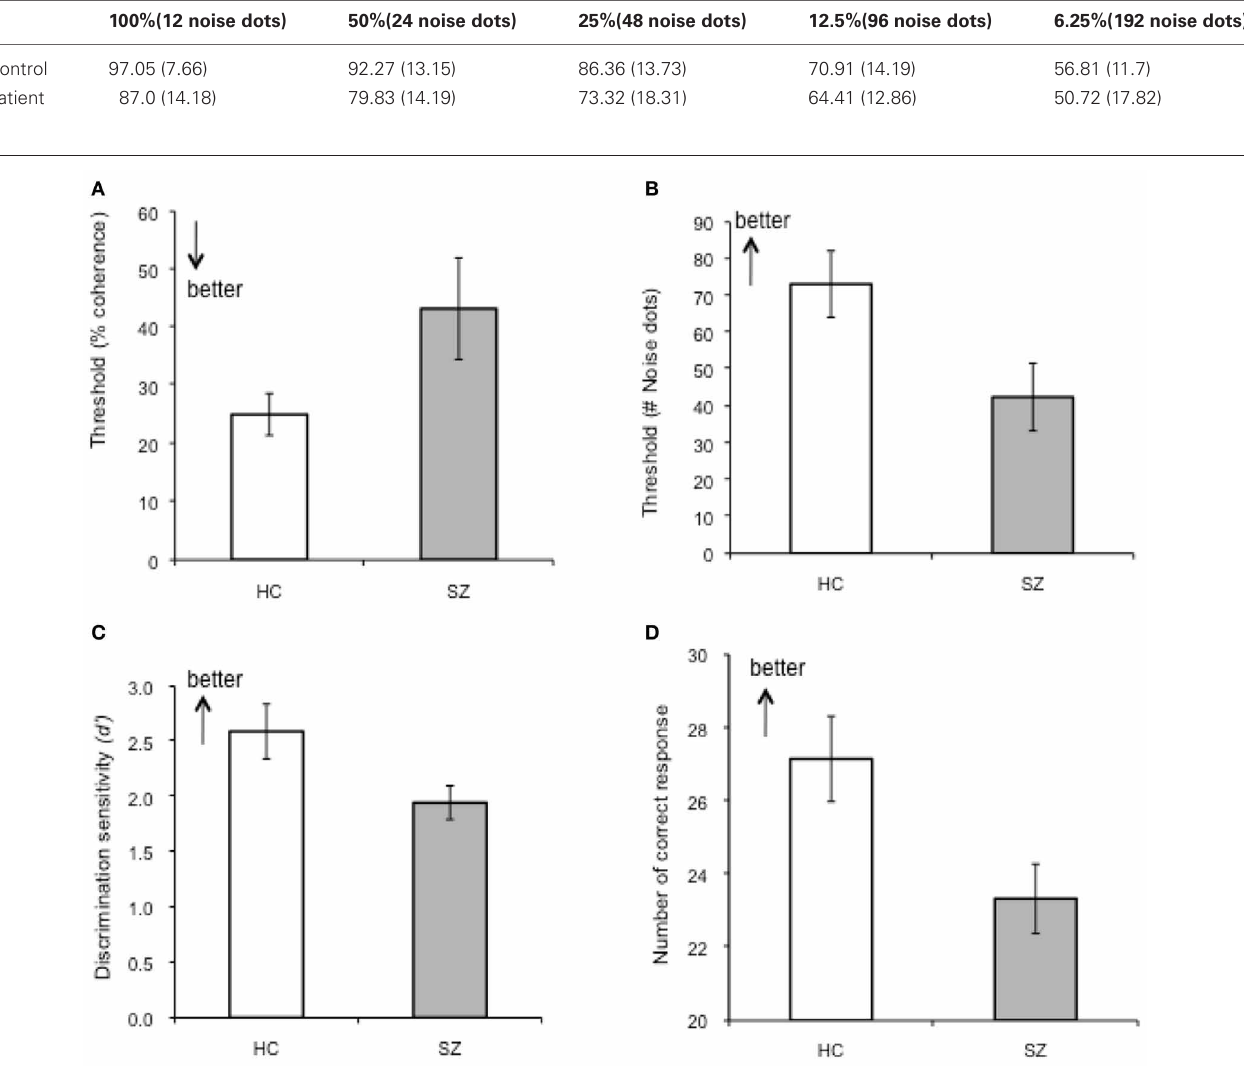
of BM (p-BM), (C) Discrimination sensitivity for recognition of BM (r-BM). (D) Accuracy for the Eyes Test. Error-bars indicate one standard error